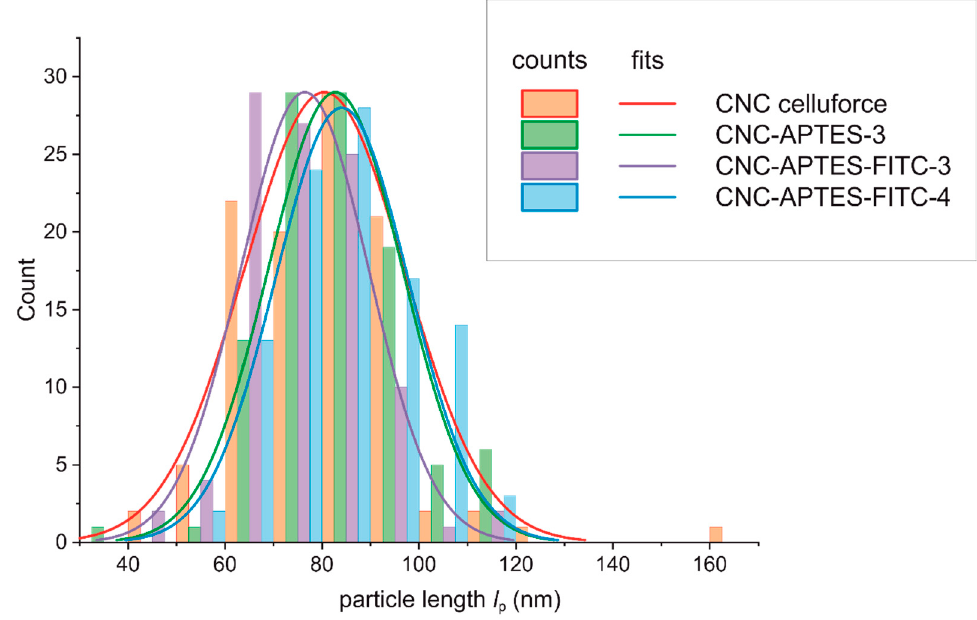
Figure 5. TEM image ( a ) non-modified CNC; ( b ) CNC-APTES-3; ( c ) CNC-APTES-FITC-3; ( d ) CNC-APTES-FITC-4.